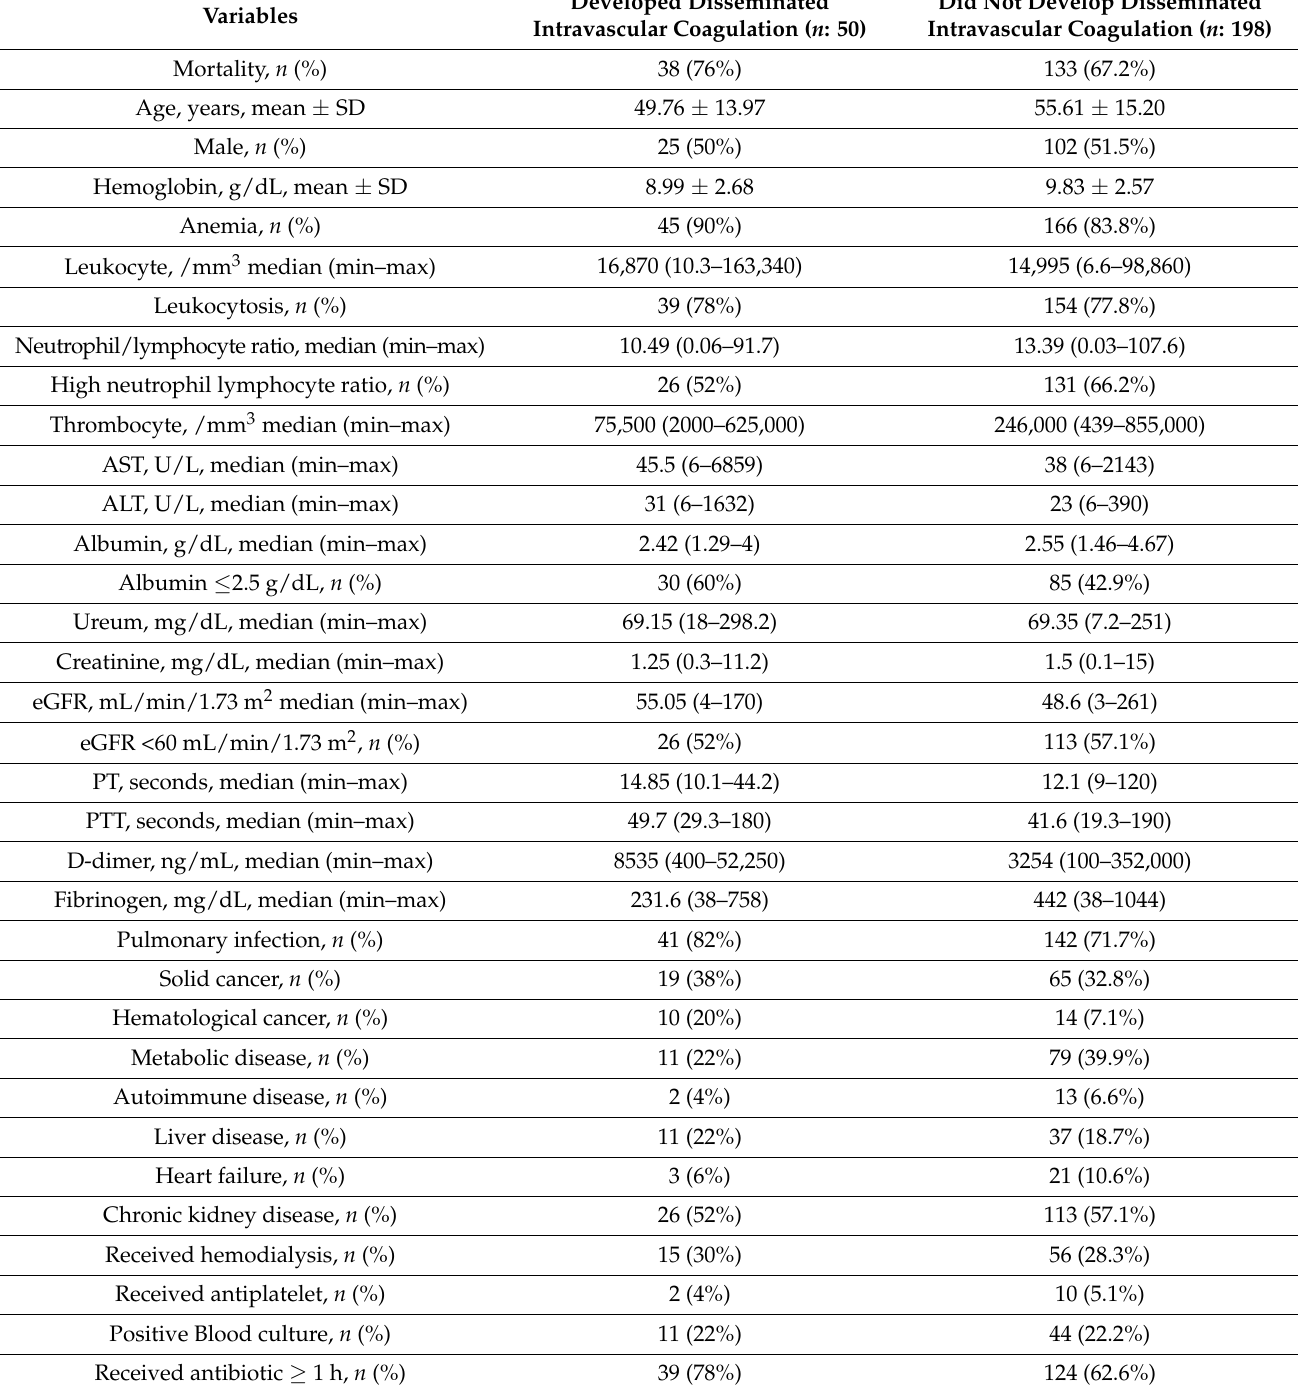
Table 1. Descriptive analysis of variables. SD, standard deviation. AST, aspartate transaminase. ALT, alanine transaminase. eGFR, estimated glomerular filtration rate. PT, prothrombin time. PTT, partial thromboplastin